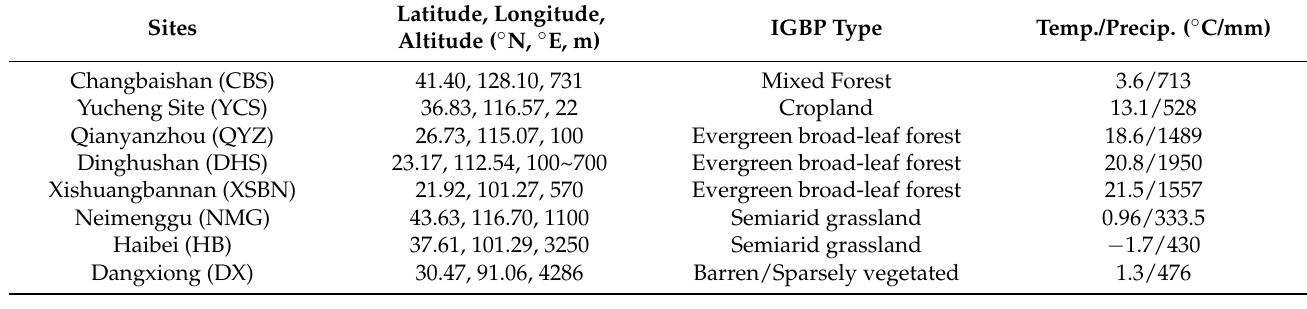
Table 1. Basic information of the 8 ChinaFlux sites for inputs evaluation.